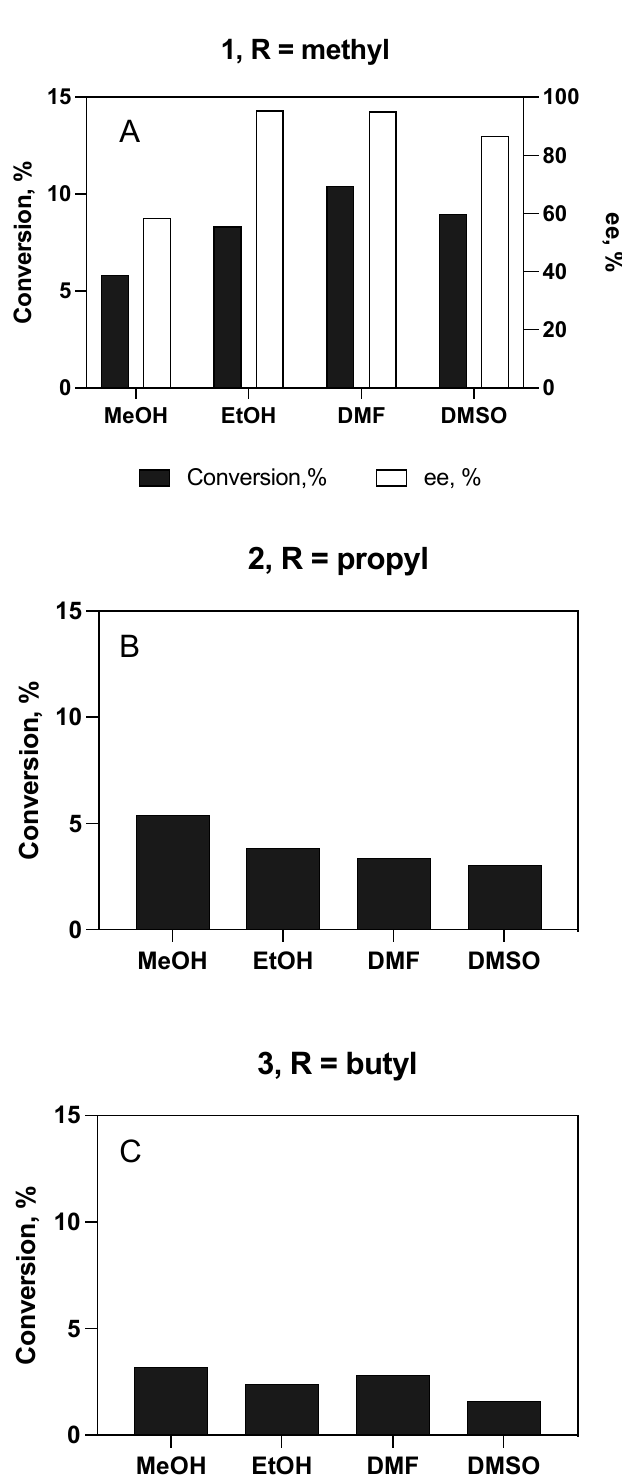
Figure 4. Hydrolysis of racemic ibuprofen esters to S-ibuprofen catalysed by KLEST-3S in phosphate buffer using different cosolvents. Substrates: ( A ) racemic ibuprofen methyl ester, ( B ) racemic ibuprofen propyl ester and ( C ) racemic ibuprofen butyl ester. Cosolvents: methanol (MeOH), ethanol (EtOH), dimethylformamide (DMF) and dimethylsulfoxide (DMSO). KLEST-3S, 8.5 Units (measured with pNP C12 with the standard method); reaction time, 24 h; temperature, 40 °C.